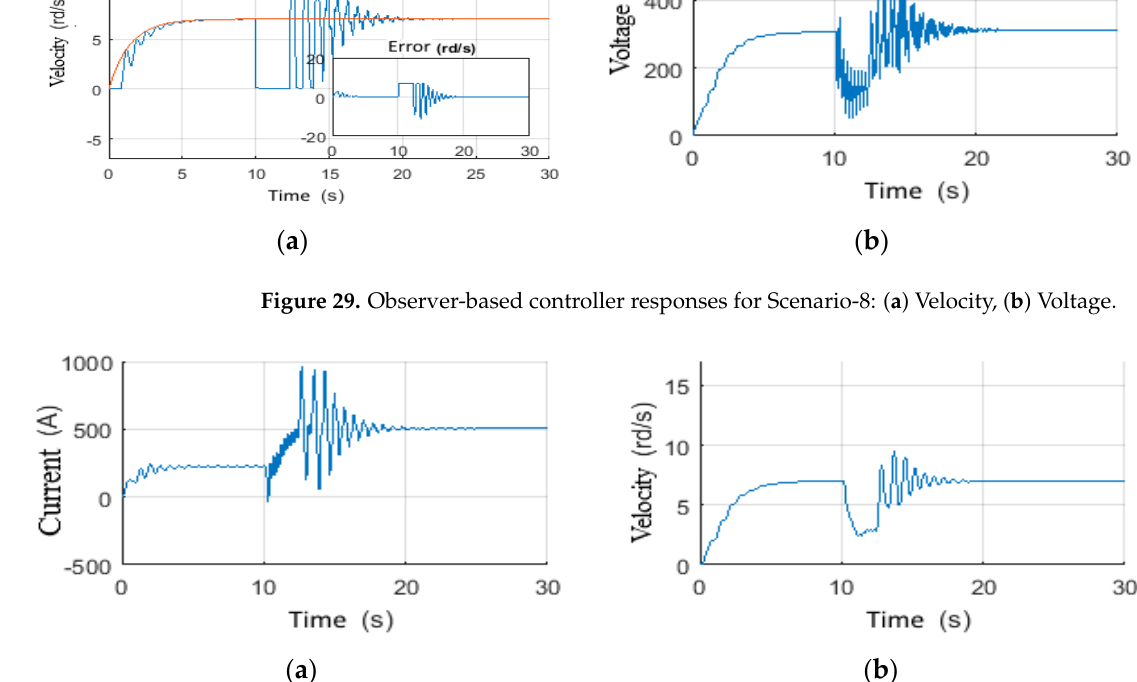
Figure 30. Observer-based controller responses of Top drive for Scenario-8: ( a ) Current, ( b ) Veloc- ity.